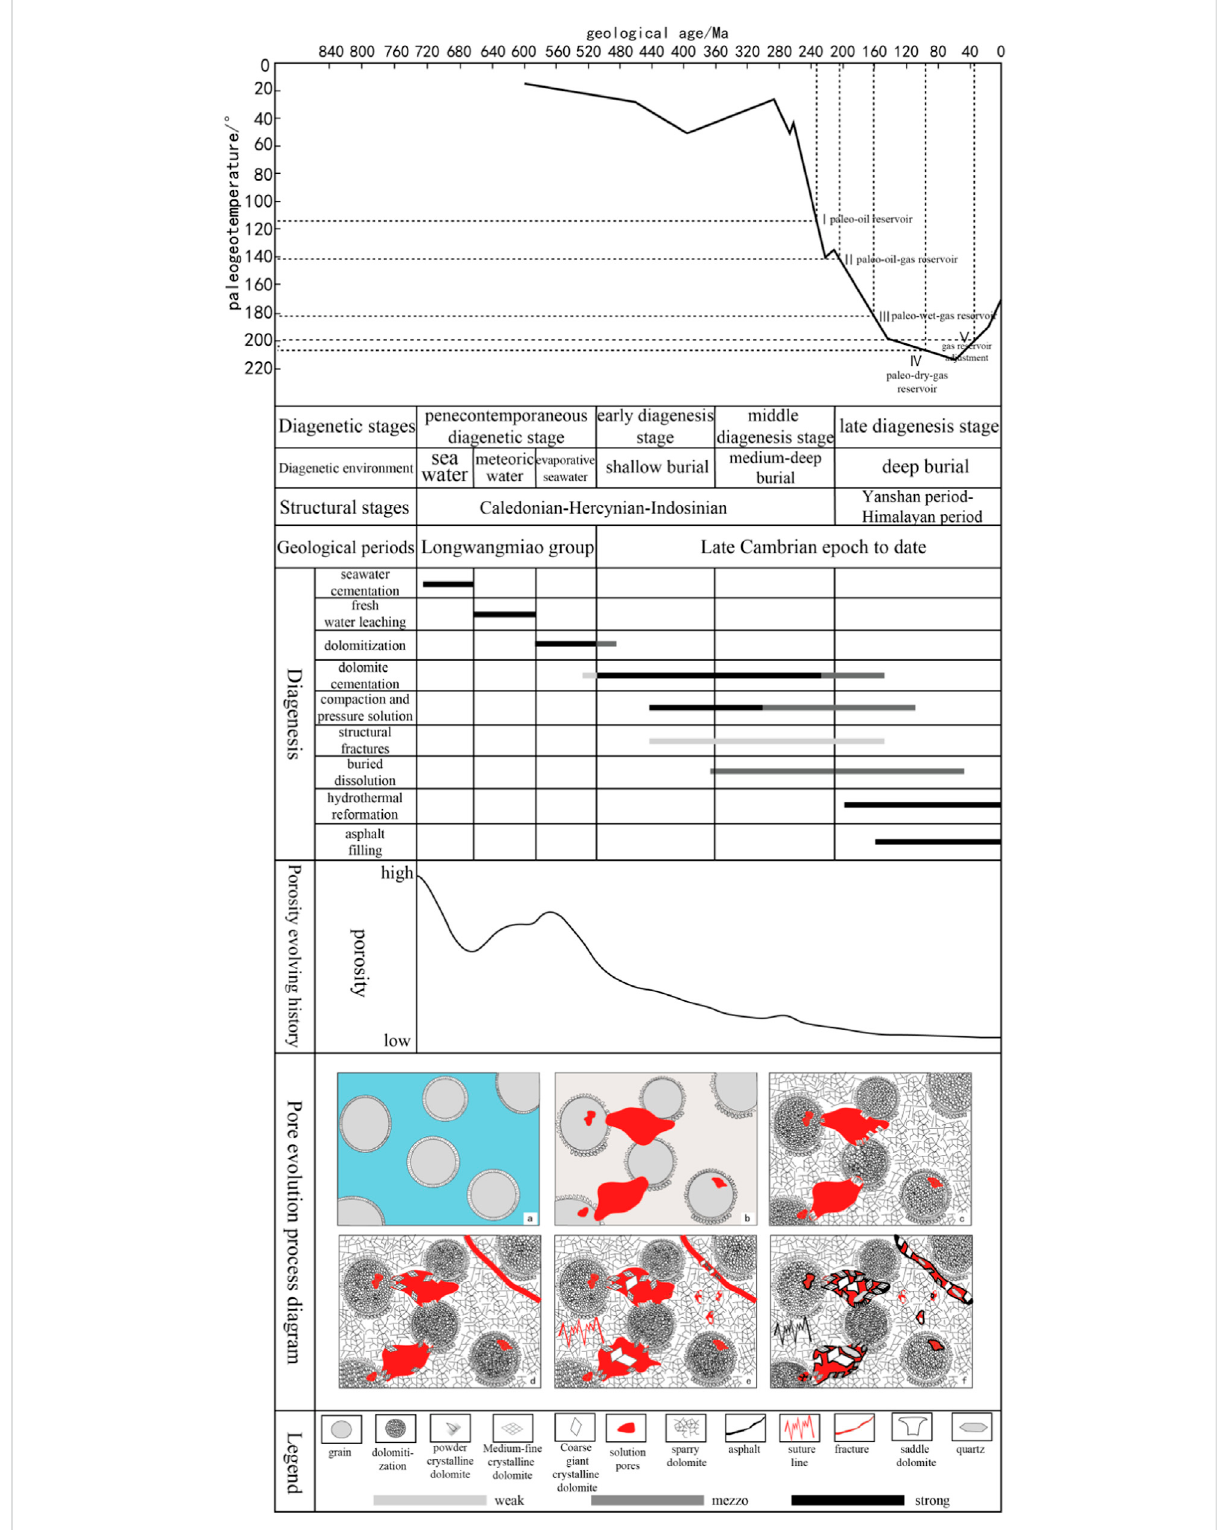
FIGURE 10 Schematic diagram of the burial history, diagenesis sequence and pore evolution of the Longwangmiao Formation in the study area. (A) is the Normal seawater stage of quasi-contemporaneous period, (B) is the Quasi-contemporaneous atmospheric freshwater stage, (C) is the Quasi- contemporaneous seawater stage, and (D) is the Early seawater stage. (E) is Middle stage, (F) is Late